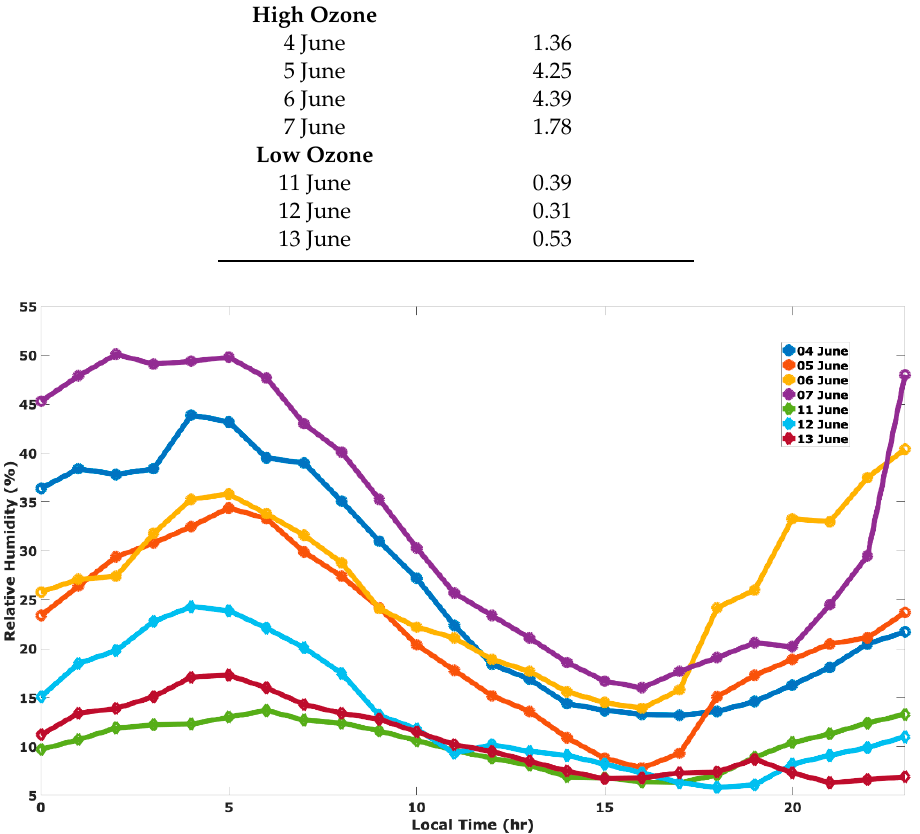
Figure 6. Percent relative humidity (%RH) during the high and low ozone episodes for the city of ELP. Data obtained from TCEQ CAMS 12. In contrary to most of the observations in the past, %RH was higher during the high ozone days and lower during the low ozone days.